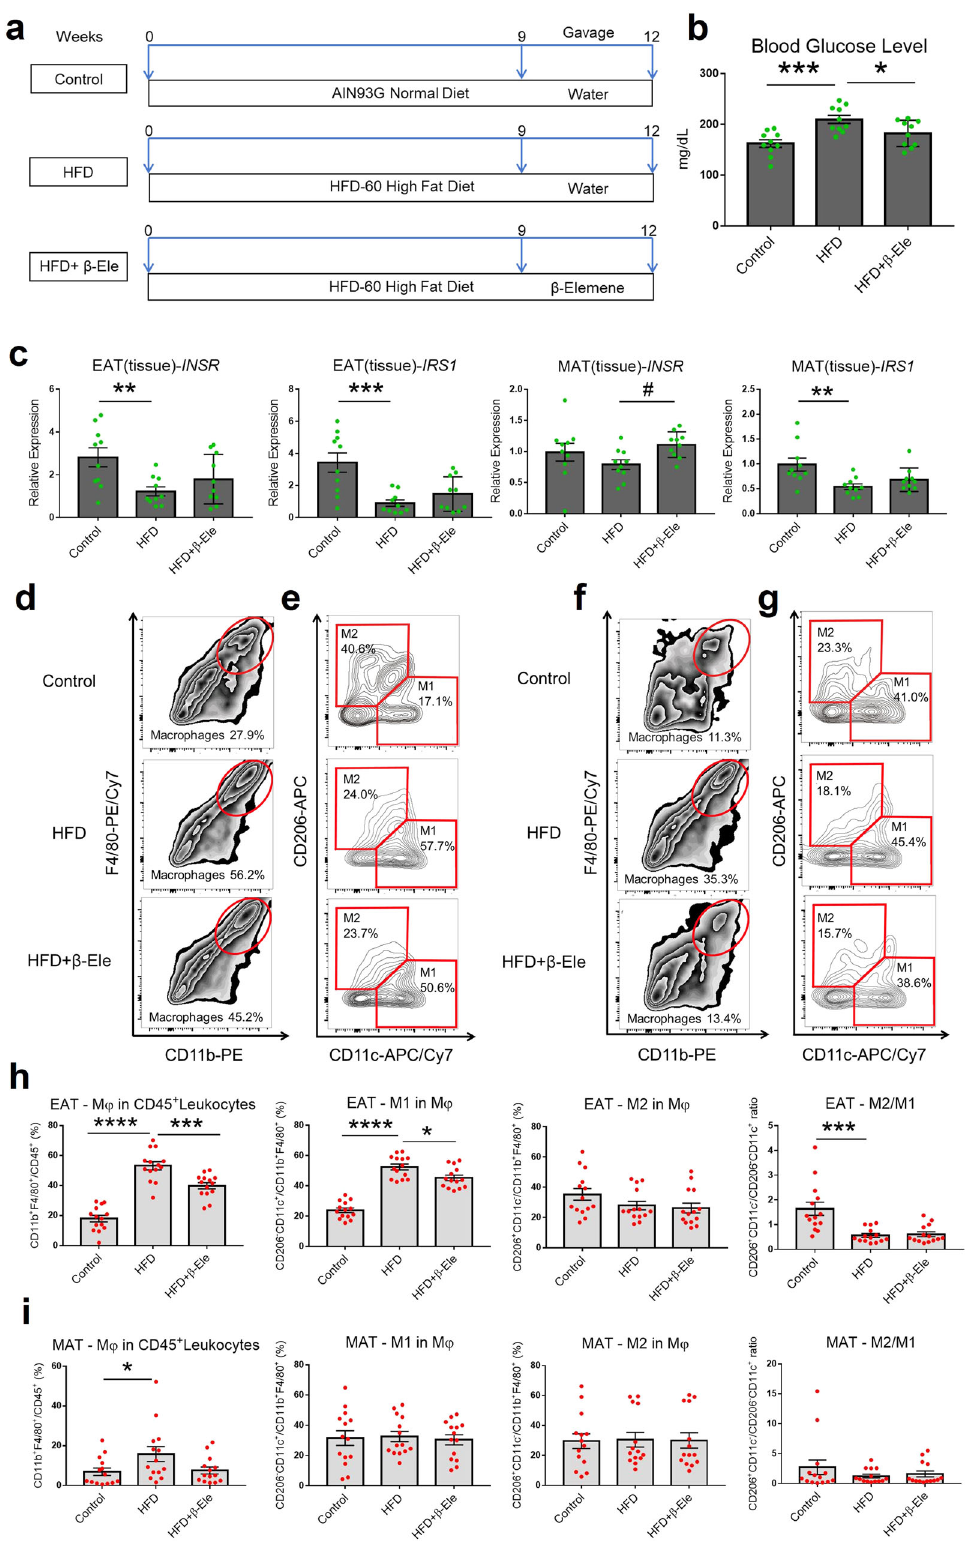
and apoptosis. In particular, it could mediate insulin resistance, which seemed to be the key point in treating obesity-induced in fl ammation 42 . Furthermore, in fl ammatory cytokines caused by obesity can affect this pathway in turn. Fig. 8a – d shows that with an increased concentration of β -elemene, the levels of the cor- responding bands of phosphorylated ERK, JNK, and p38